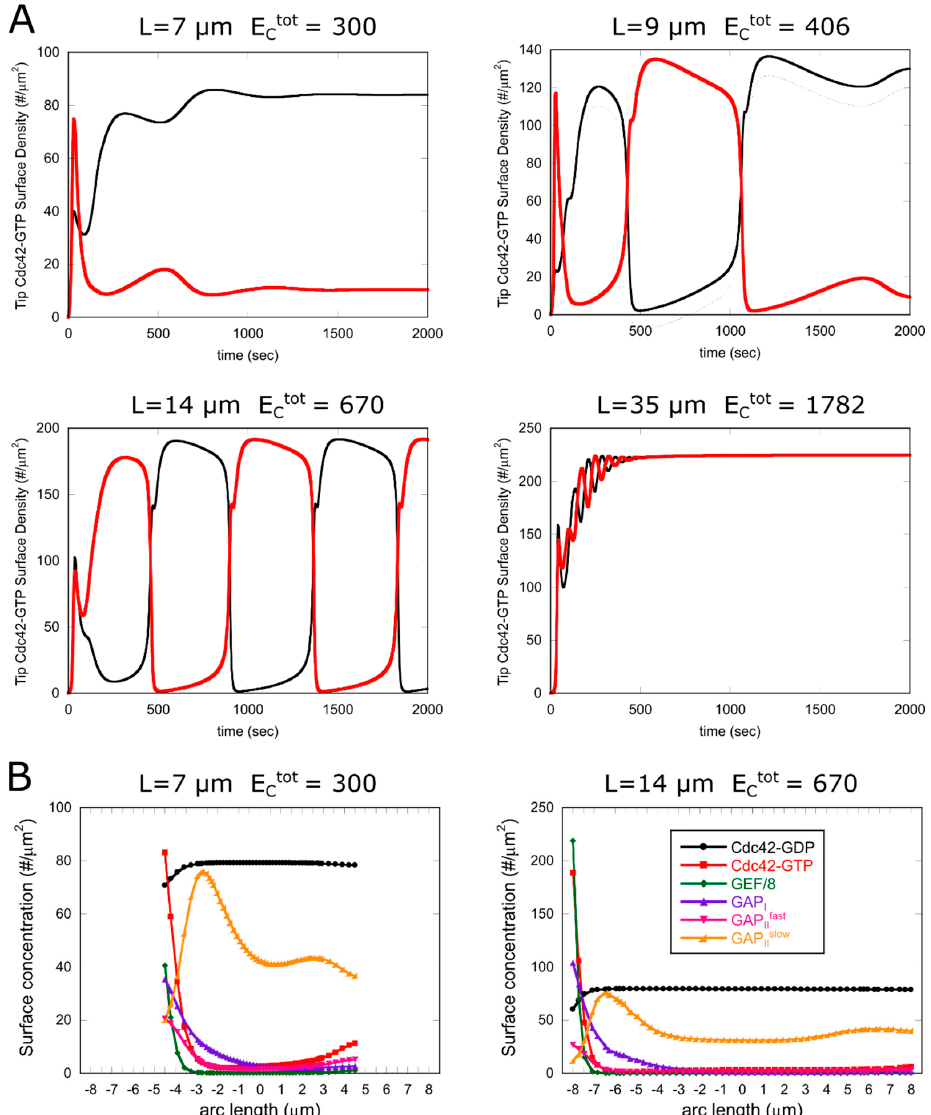
Figure 6. Results of simulations at different fixed cell lengths, L, and increasing the total GEF in proportion to cell volume, as indicated in each graph. Other parameters same as Table 1, except for k sat = 650 / µ m 2 . ( A ) Plots of Cdc42-GTP concentration at each tip (red and black curve) as a function of time starting from an unpolarized state with both tips inactive. System transitions from MPDO to BPO and BPS with increasing L . ( B ) Concentrations as a function of arc length distance from cell tip for a cell of length 7 μ m (left, at steady asymmetric state) and length 14 μ m (right, after 1060 s of simulation of cell undergoing symmetric oscillations, at an instant with a dominant left tip).